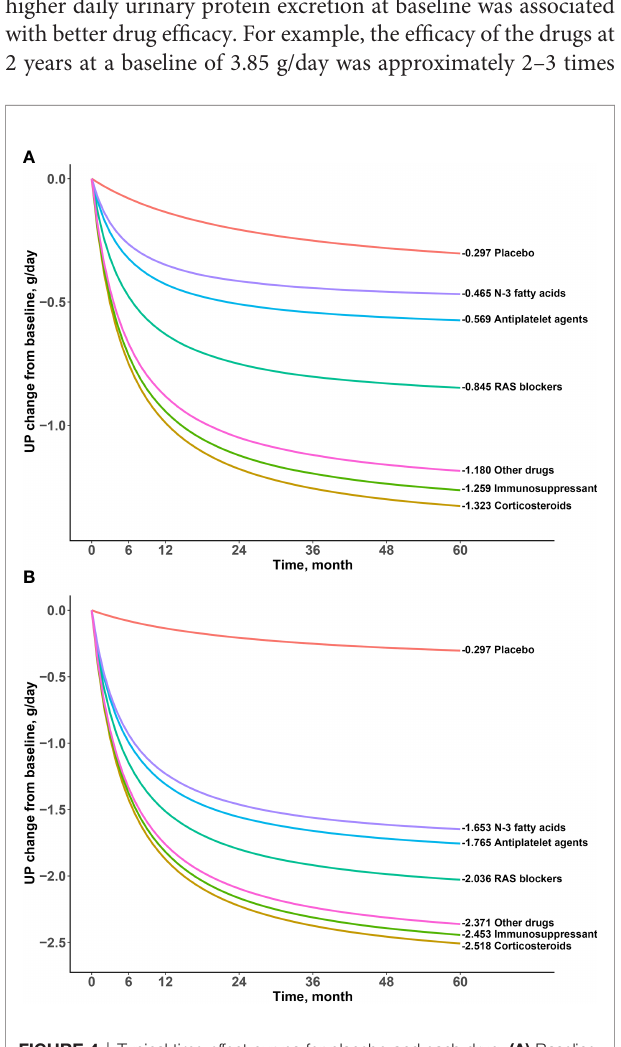
FIGURE 4 | Typical time-effect curves for placebo and each drug. (A) Baseline urine protein was 1.80g/day (B) Baseline urine protein was and